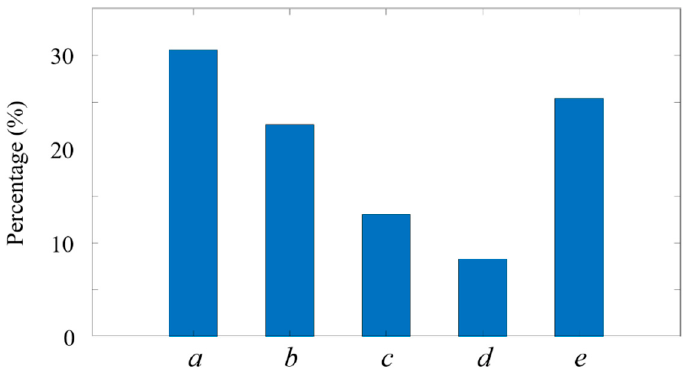
Figure 14. Percentage of fluorescent micropillars passing through ADLS. (a) 0.2 µ m ≤ d p ≤ 0.4 µ m, (b) 0.4 µ m < d p ≤ 0.6 µ m, ( c ) 0.6 µ m < d p ≤ 0.8 µ m, (d) 0.8 µ m < d p ≤ 1 µ m, (e) d p > 1 µ m.